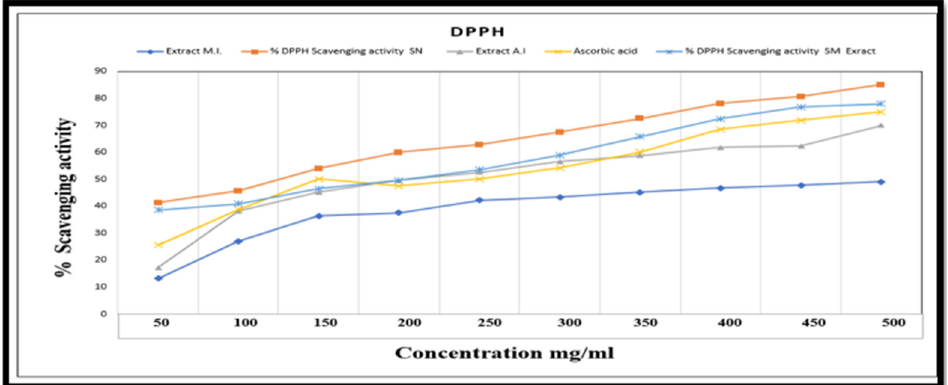
Figure 11. Antioxidant activity of A-Ag (SN-Silver NPs), M-Ag (SM-Silver NPs ), and their plant ex-